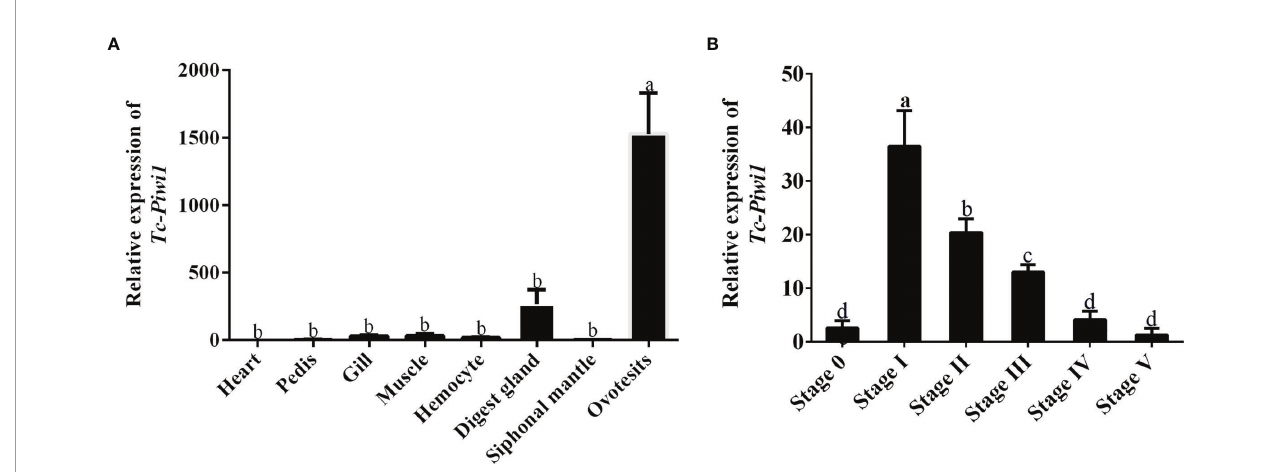
FIGURE 3 | Expression pro fi les of Tc-Piwi1 in (A) different tissues and (B) adult six gonad developmental stages by qRT-PCR. Stage 0 to stage V represent the undifferentiated stage, the male-dominated bisexual-phase gonad, the oocyte growing stage in ovotestis, the oocyte mature stage I in ovotestis, the oocyte mature stage II in ovotestis, and the oocyte regression stage in the ovary, respectively. b -Actin was used as a reference gene. Data are represented as the mean ± SD (N = 3), bars not sharing with the same letter are signi fi cantly differed at p <